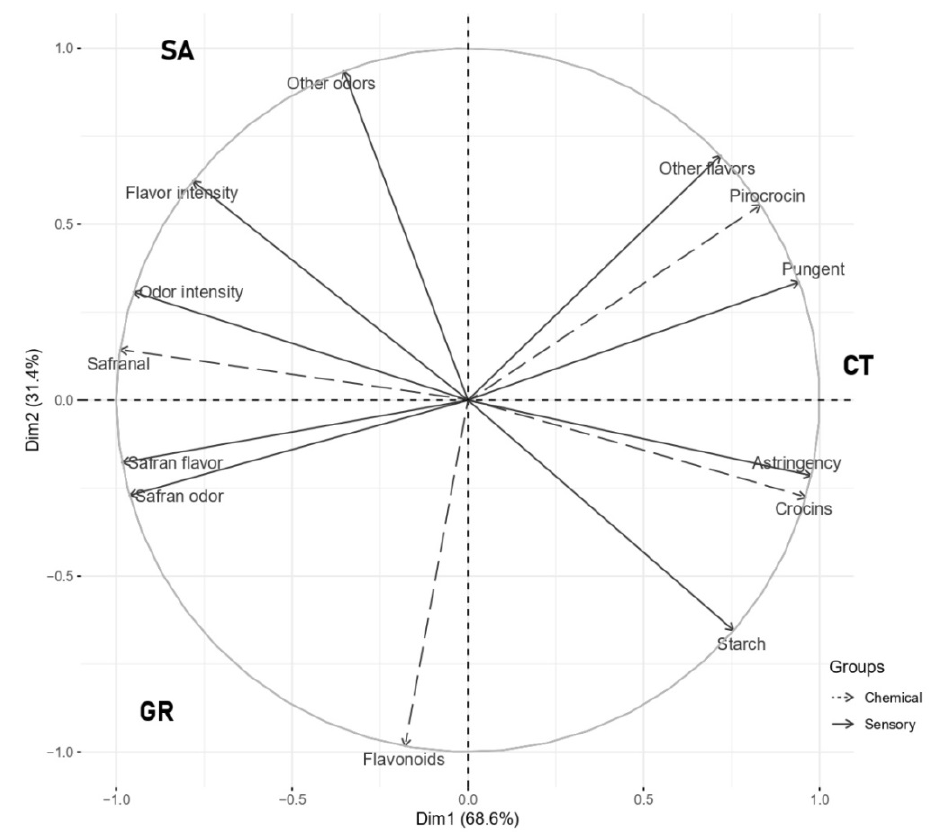
Figure 2. Multiple Factor Analysis map. The map describes correlation between sensory attributes (continuous arrows) and the main saffron compounds chemically analysed (dashed arrows). SA, CT, GR mark the graph dials related to Sardinian, Central Tuscany and Southern Tuscany saffron, respectively.